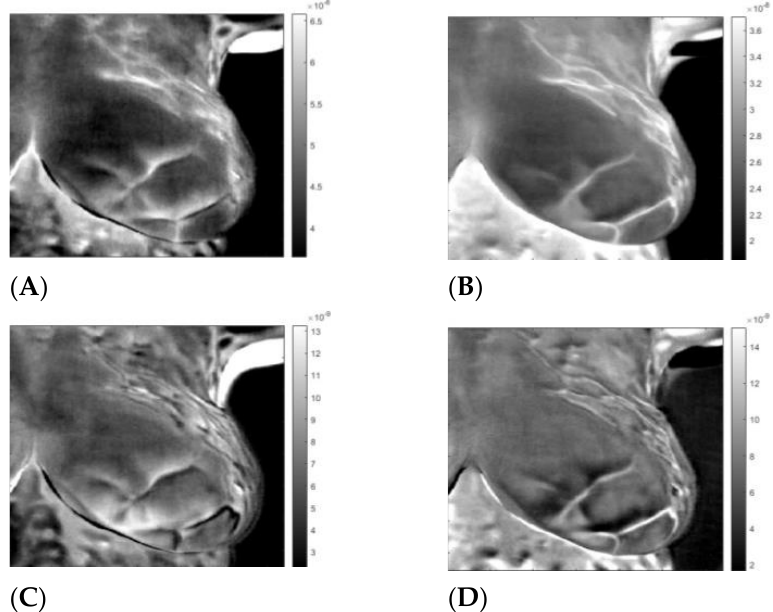
Figure 7. Sick left breast of patient “T281.” Images A to D after application of the inverse ICA transform. ( A , B ) are images of thermal reflection, while ( C , D ) are images of vasoconstriction.